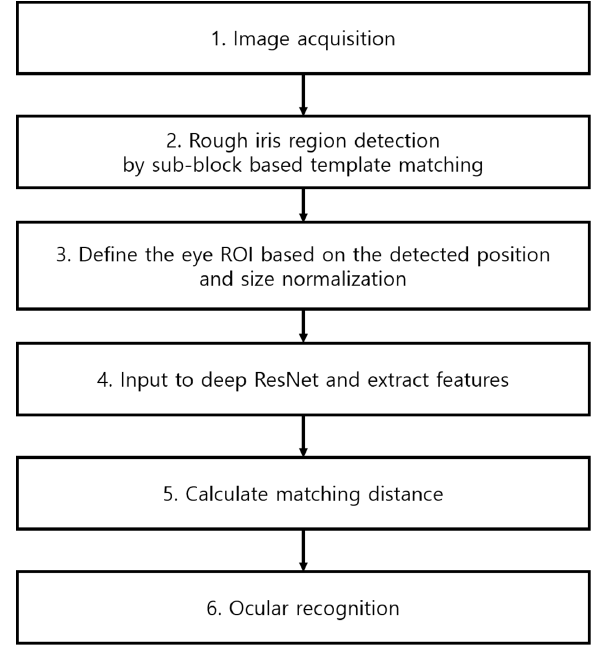
Figure 1. Overview of the proposed system.